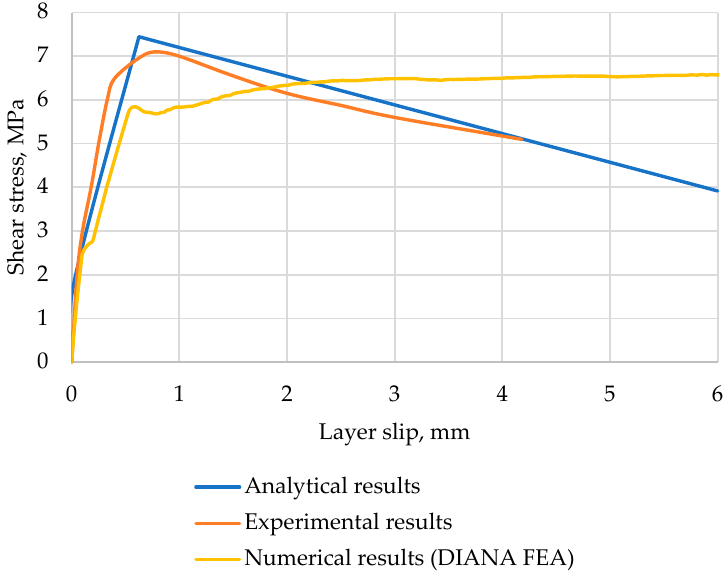
Figure 9. Shear stress–layer slip curves of specimen S-C65L40-6D10-Ba.